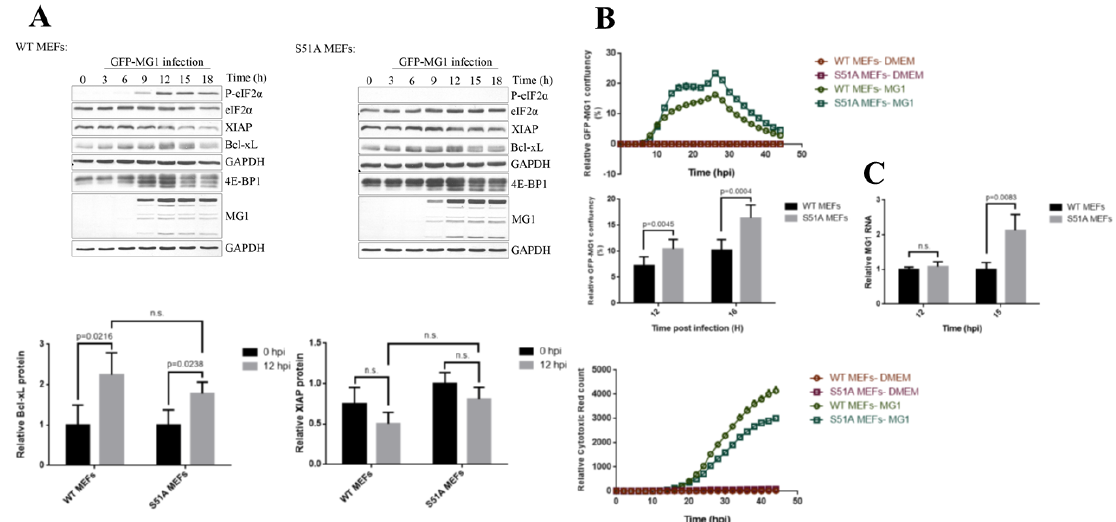
Figure 4. The levels of MG1 proteins and up-regulation of Bcl-xL protein are independent of eIF2 α phosphorylation. ( A ) Western blot analysis from the time course infection of WT and S51A MEFs with MG1 at MOI = 0.1 demonstrates the levels of Bcl-xL, XIAP proteins and de-phosphorylation of 4E-BP1. GAPDH is shown as the loading control. Relative Bcl-xL and XIAP expression levels to GAPDH at 12 hpi were normalized to uninfected cells (Bottom). ( B ) Top: IncuCyte live cell imaging demonstrates the confluency of GFP signal in WT and S51A MEFs in real time. Y axis depicts the percentage of GFP-MG1 infected cells relative to total cell confluency. Middle: Fold GFP-MG1 confluency between the two cell lines was quantified at 12 and 16 hpi. Bottom: Cytotox Red reagent was used in cells mock-infected or infected with MG1 virus and the activity of the fluorescent red dye was monitored over a time course. Y axis represents the number of cells emitting fluorescent red (dead cells) relative to the cell confluency. ( C ) MG1 genomic RNA was measured relative to the geometric mean of RPL13A and PPIA mRNAs in WT and S51A MEFs at 12 and 15